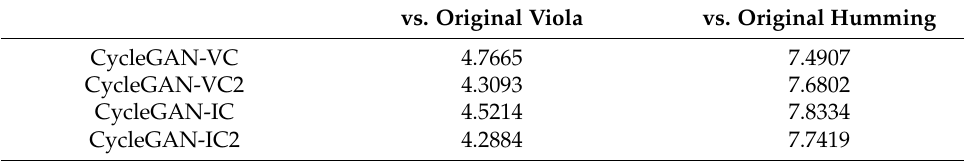
Table 3. The average MCD of the converted viola with the original viola/humming. vs. Original Viola